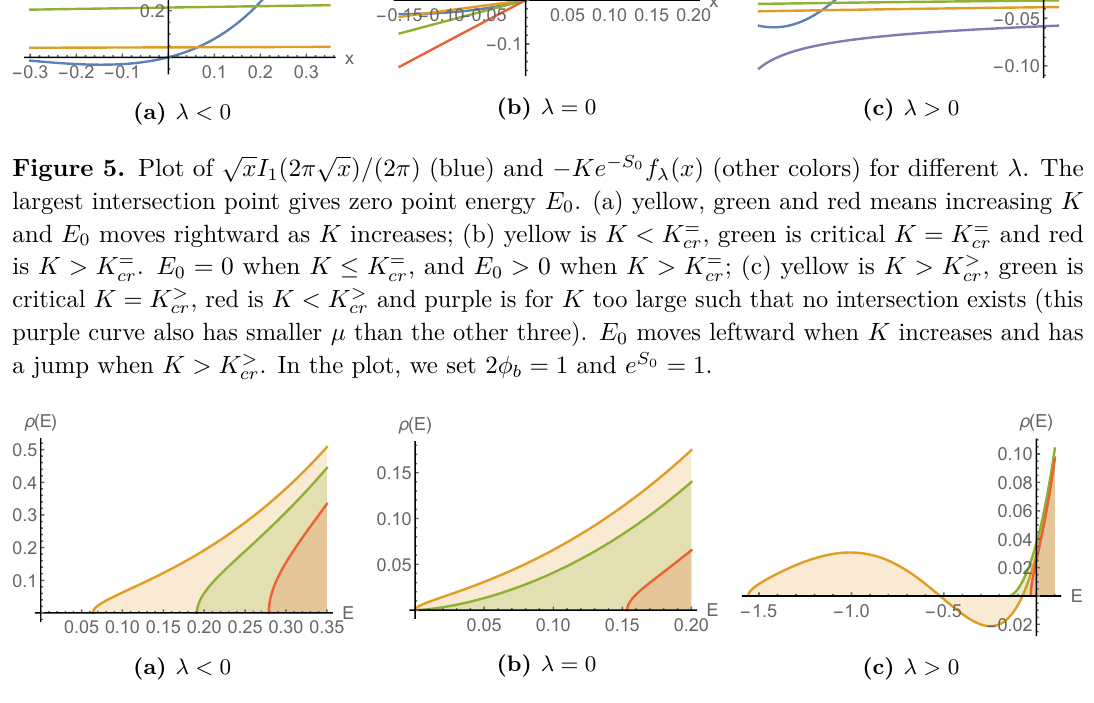
and red cr , green is cr